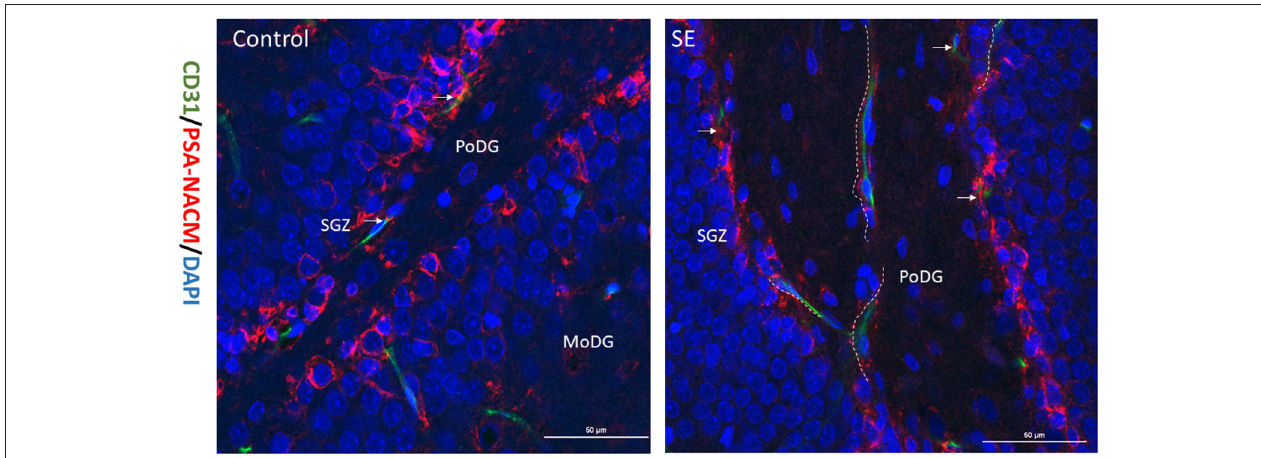
FIGURE 2 | Relationship between migrated NSCs and neovascularization. The expression of CD31 and PSA-NACM in the hippocampal DG at 7 days post SE in immature rats. PSA-NACM was stained prominently in the granule cells of SGZ (arrows) and is tributions of CD31 at the polymorphic layer of the DG (PoDG) or molecular layer of the DG (MoDG) in the hippocampus. PSA-NACM colocalized with CD31 expressed in hundreds of microns in the direction of PoDG after SE. It indicated that NSCs migrated hundreds of microns from the SGZ in the direction of new blood vessels. CD31, green; PSA-NACM, red; scale bar, 50 µ m.